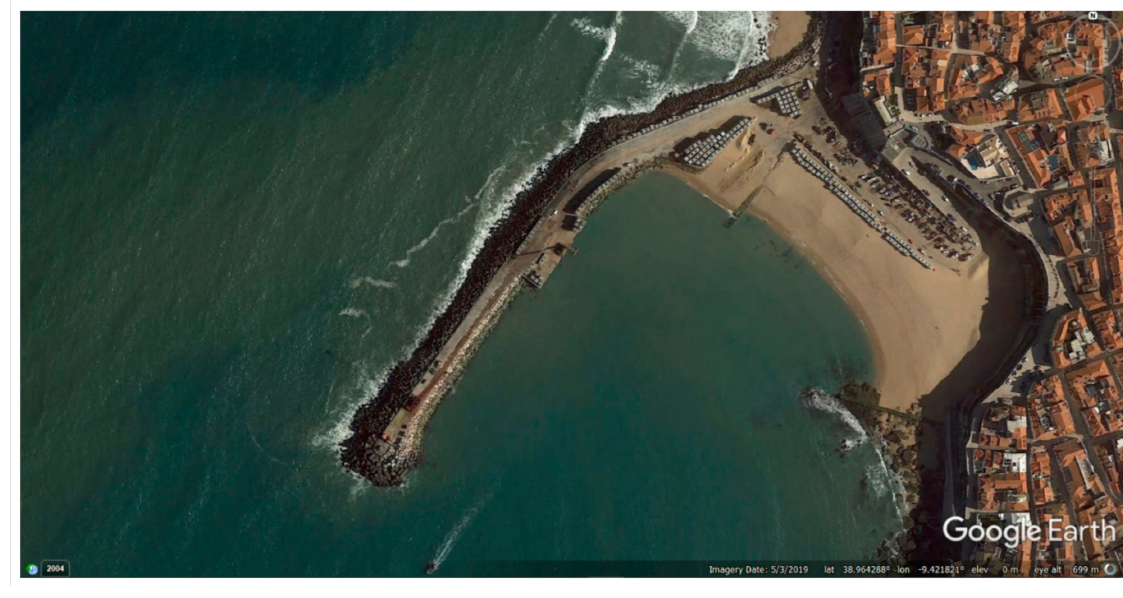
Figure 1. Aerial view of Ericeira breakwater (Google Earth).